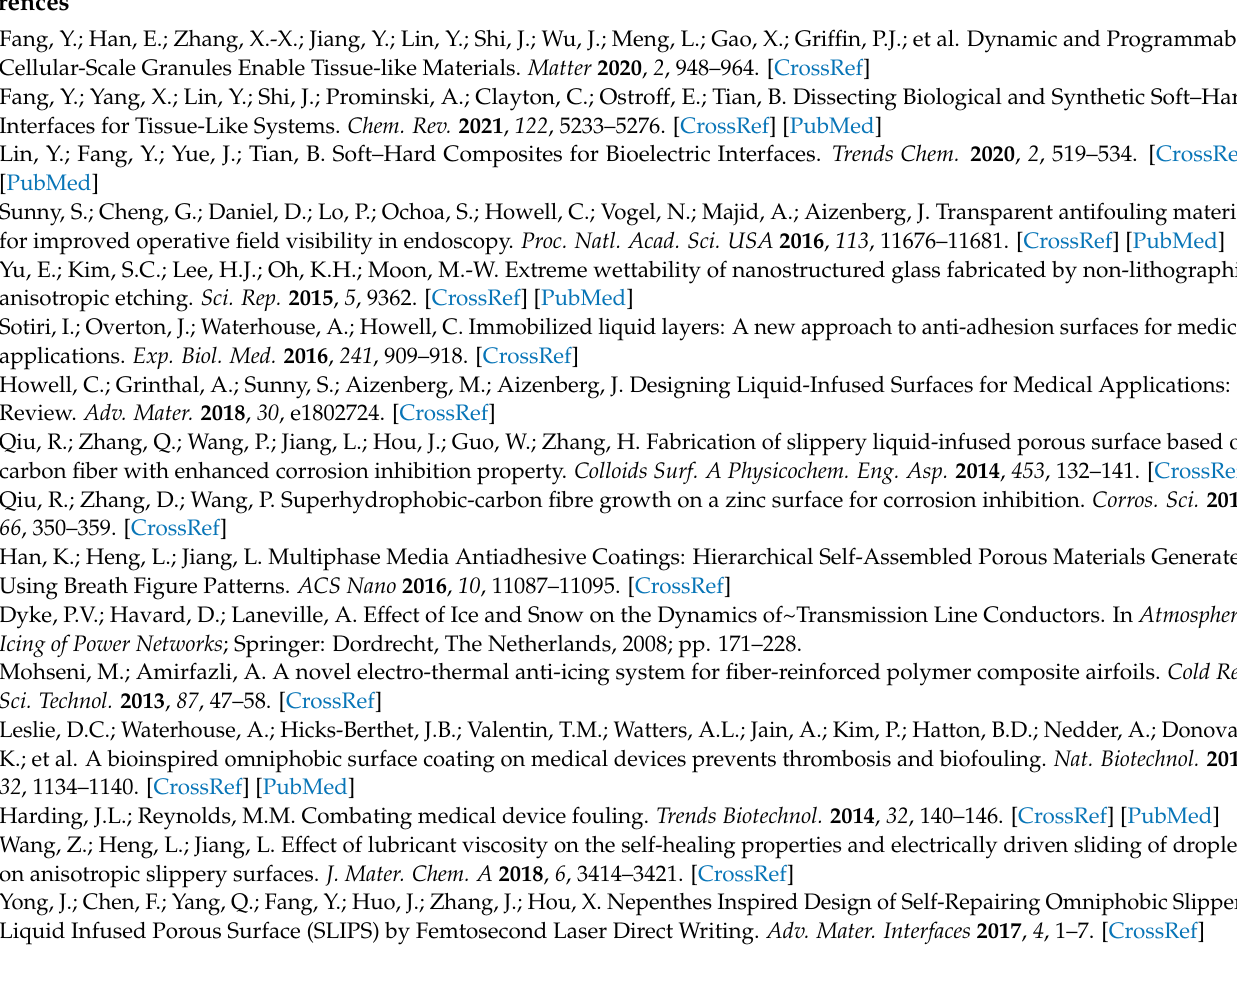
centration; Figure S2: Plots of pore size versus spinning speed; Figure S3: The side-view SEM photo of porous film; Figure S4: Contact angles of different droplets on the surface of a dry porous